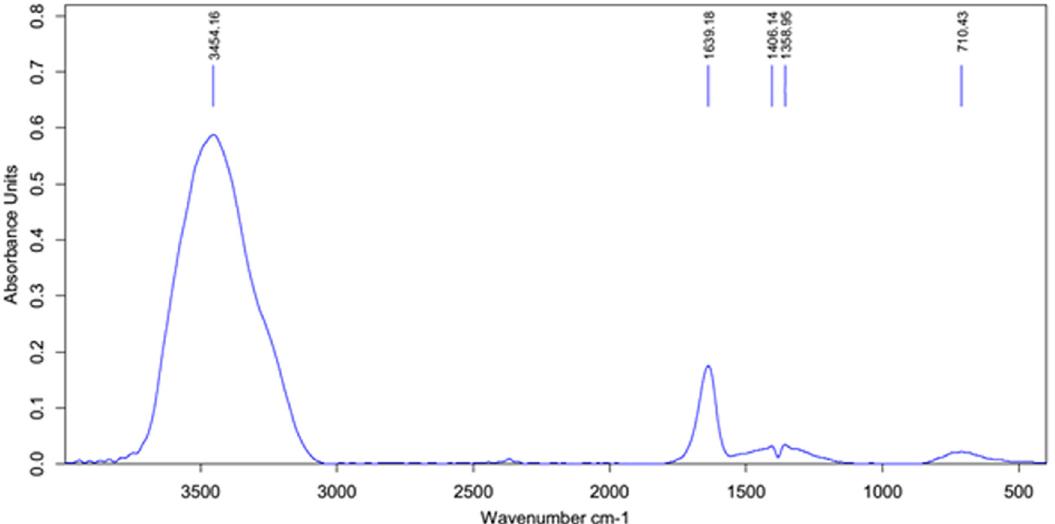
Figure 1: FTIR spectra of the co ff ee bean